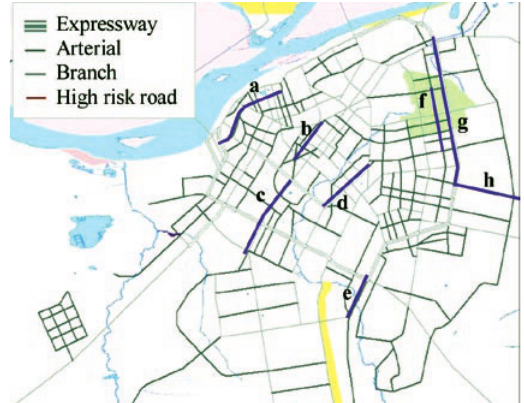
Fig. 4. Hongqi Str. as a case study road: 1: three specific intersections; 2: risk crossing behavior; 3: ‘729’ accident site.